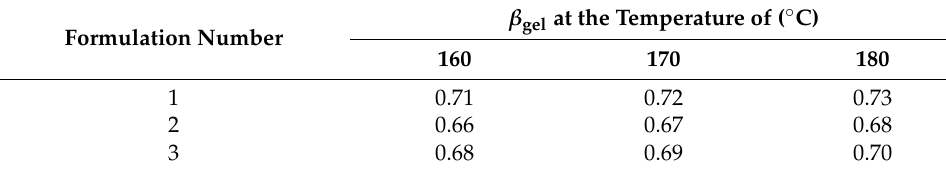
Table 5. The degrees of conversion at the points of gelation for formulations 1–3. Formulation Number